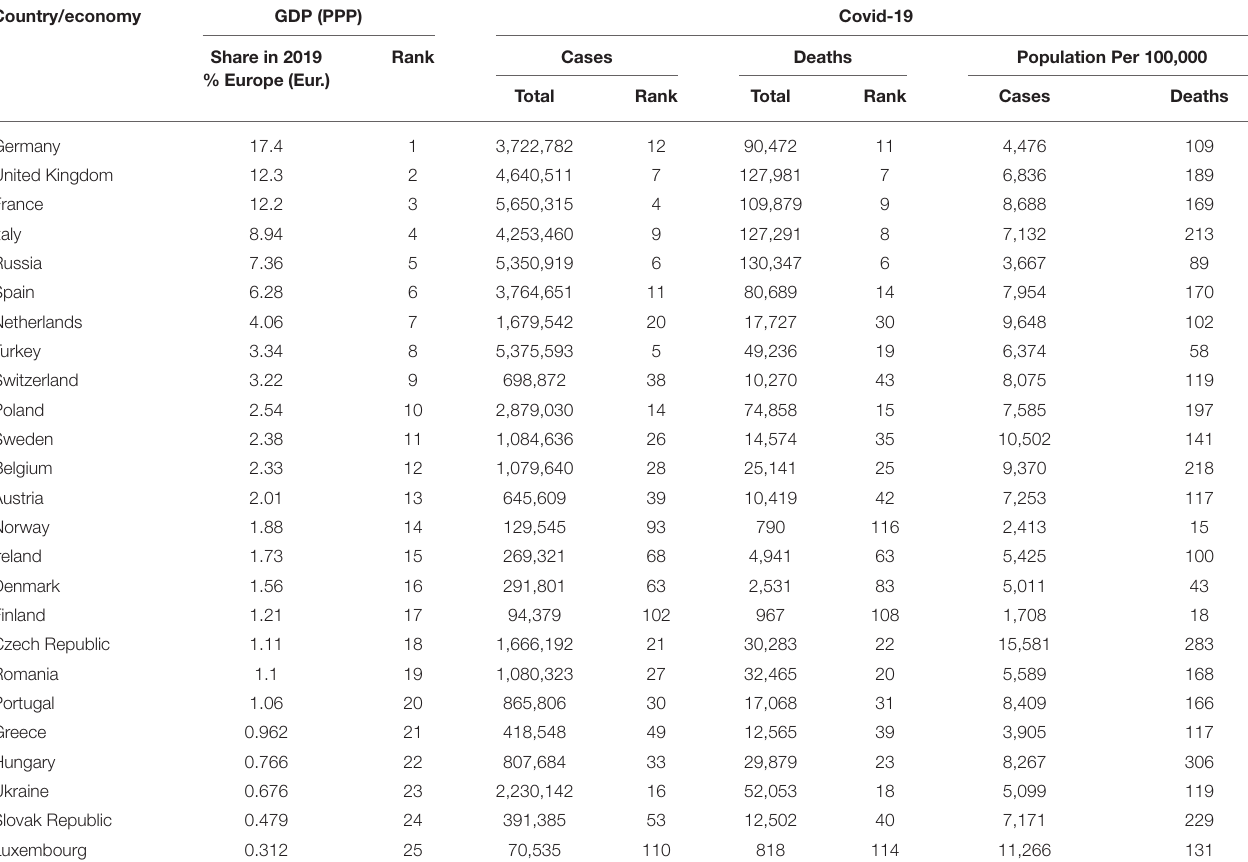
TABLE 1 | Ranking of the GDP and the situation of Covid-19 in European states. Country/economy GDP (PPP) Covid-19 Share in 2019 Rank Cases Deaths Population Per 100,000 % Europe (Eur.) Total Rank Total Rank Cases